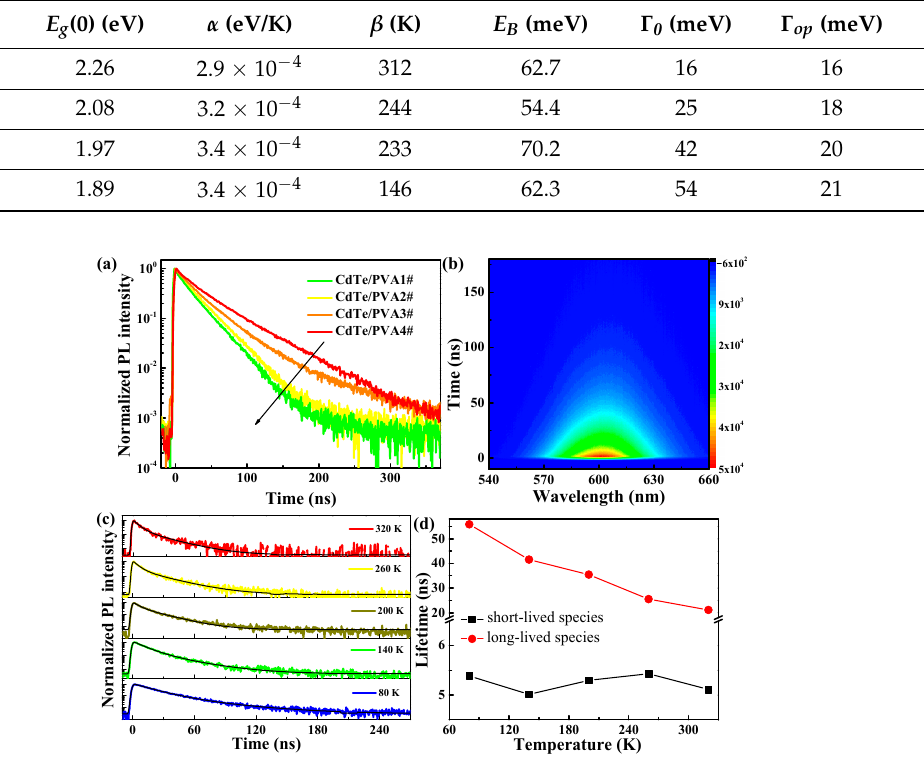
Table 1. Fitted parameters in terms of Equations (1)–(3).